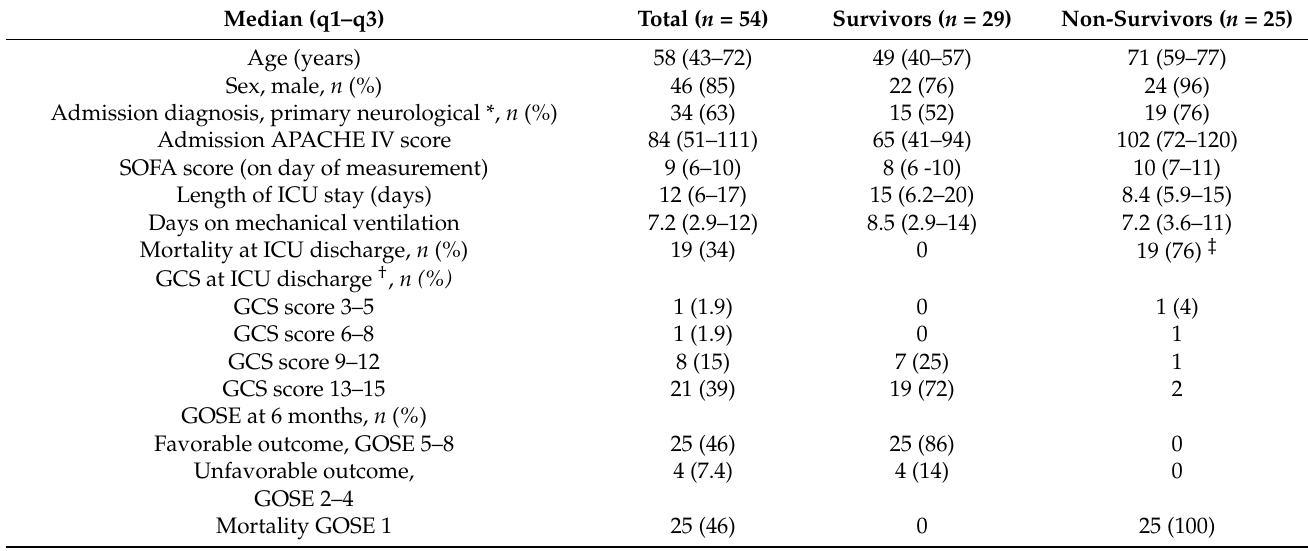
Table 2. Patient characteristics dichotomized for six-month mortality.